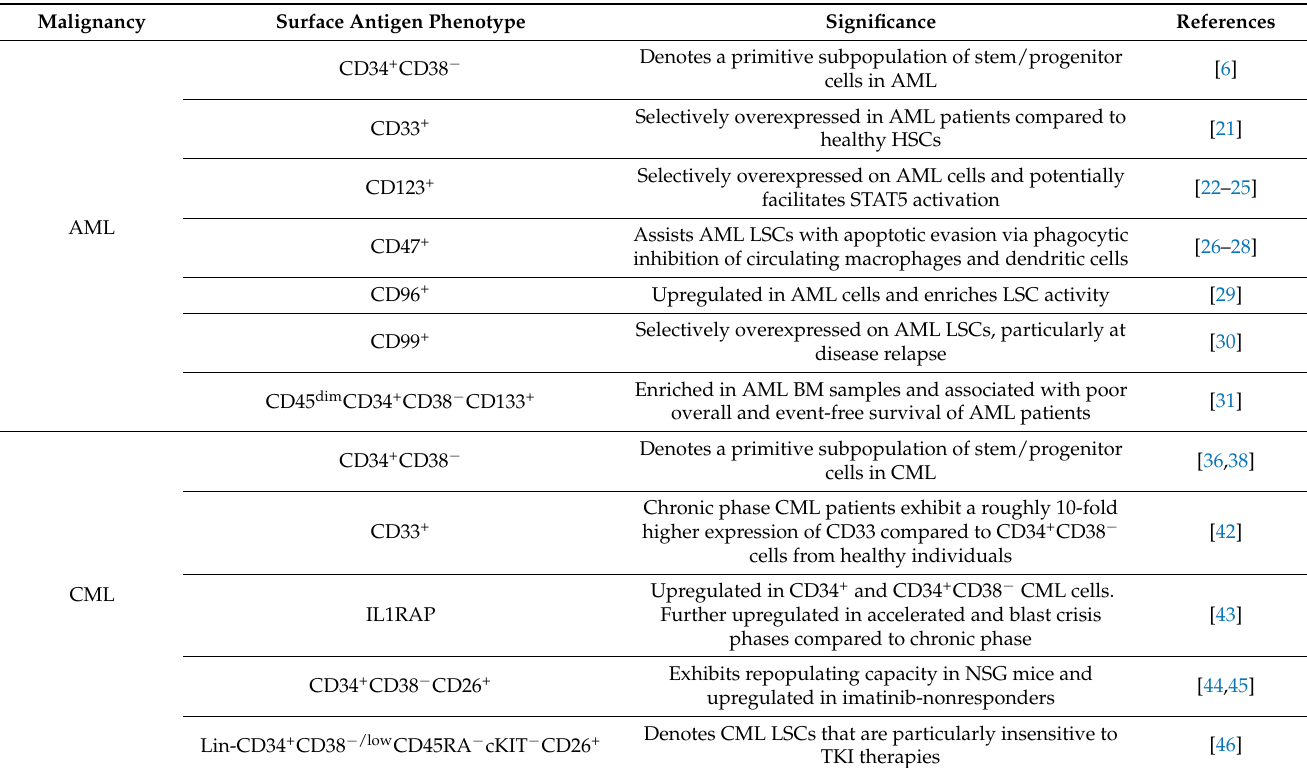
Table 1. Surface Antigen Phenotypes of AML and CML